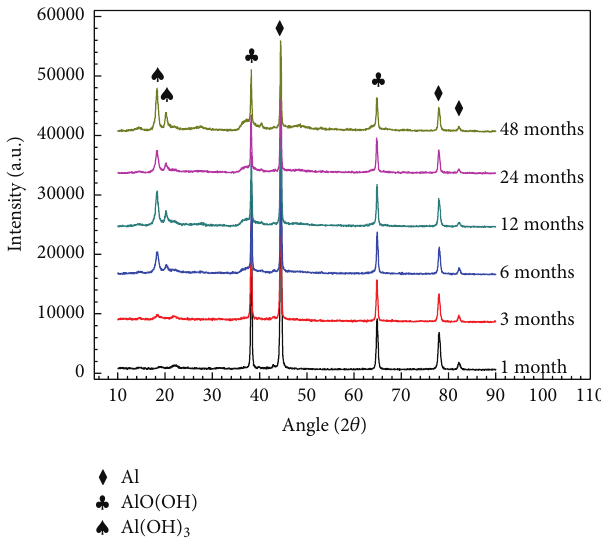
Figure 10: XRD patterns of the corrosion products formed on 2A12 aluminum alloy after different exposure